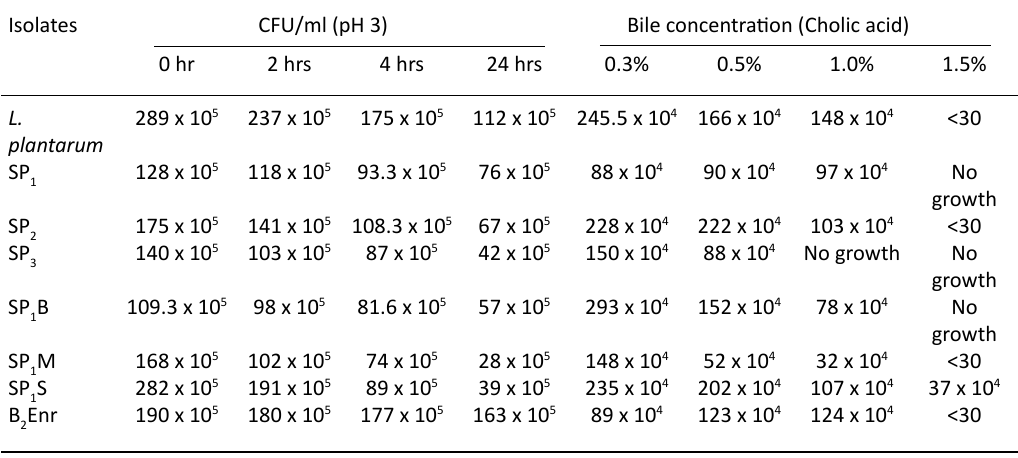
Table 1. Acid and Bile tolerance properties of the different isolates